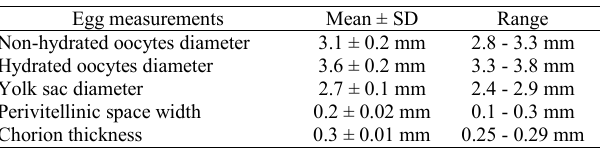
Table 3. Means of the non-hydrated and hydrated oocytes diameter, yolk sac diameter, perivitellinic space width and chorion thickness after induced spawning in females of Lophiosilurus alexandri (N =